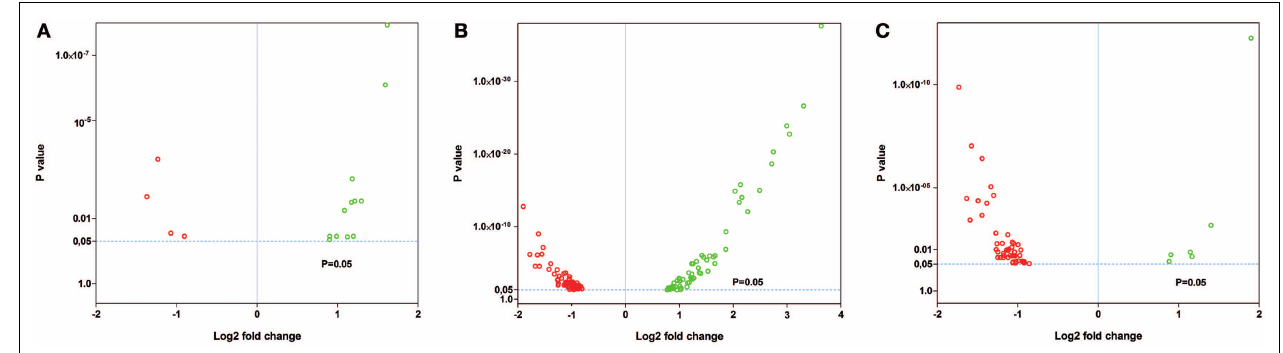
FIGURE 5 |Volcano plots of the significant gene expression changes inTg4–42 and 5XFAD mice . Fold changes in gene expression of (A) young 5XFAD, (B) aged 5XFAD, and (C) agedTg4–42 mice. Each dot represents one gene. Dashed lines illustrate statistical significance ( p = 0.05). Red, down-regulated; green,